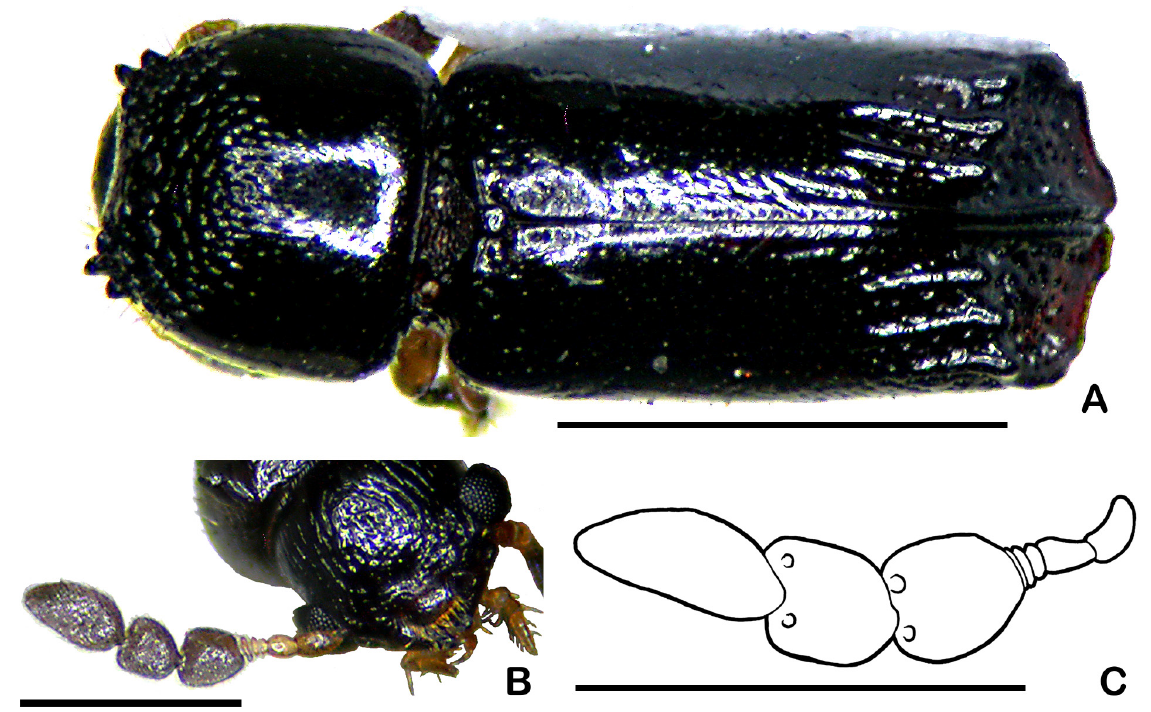
Fig. 1. Octomeristes pusillus Liu & Beaver, gen. et sp. nov., paratype (LYL). A . Dorsal view. B . Front view of head and right antenna. C . Antenna showing position of impressed sensory areas on 6 th and 7 th antennomeres. Scale bars: A = 1 mm; B–C = 0.5